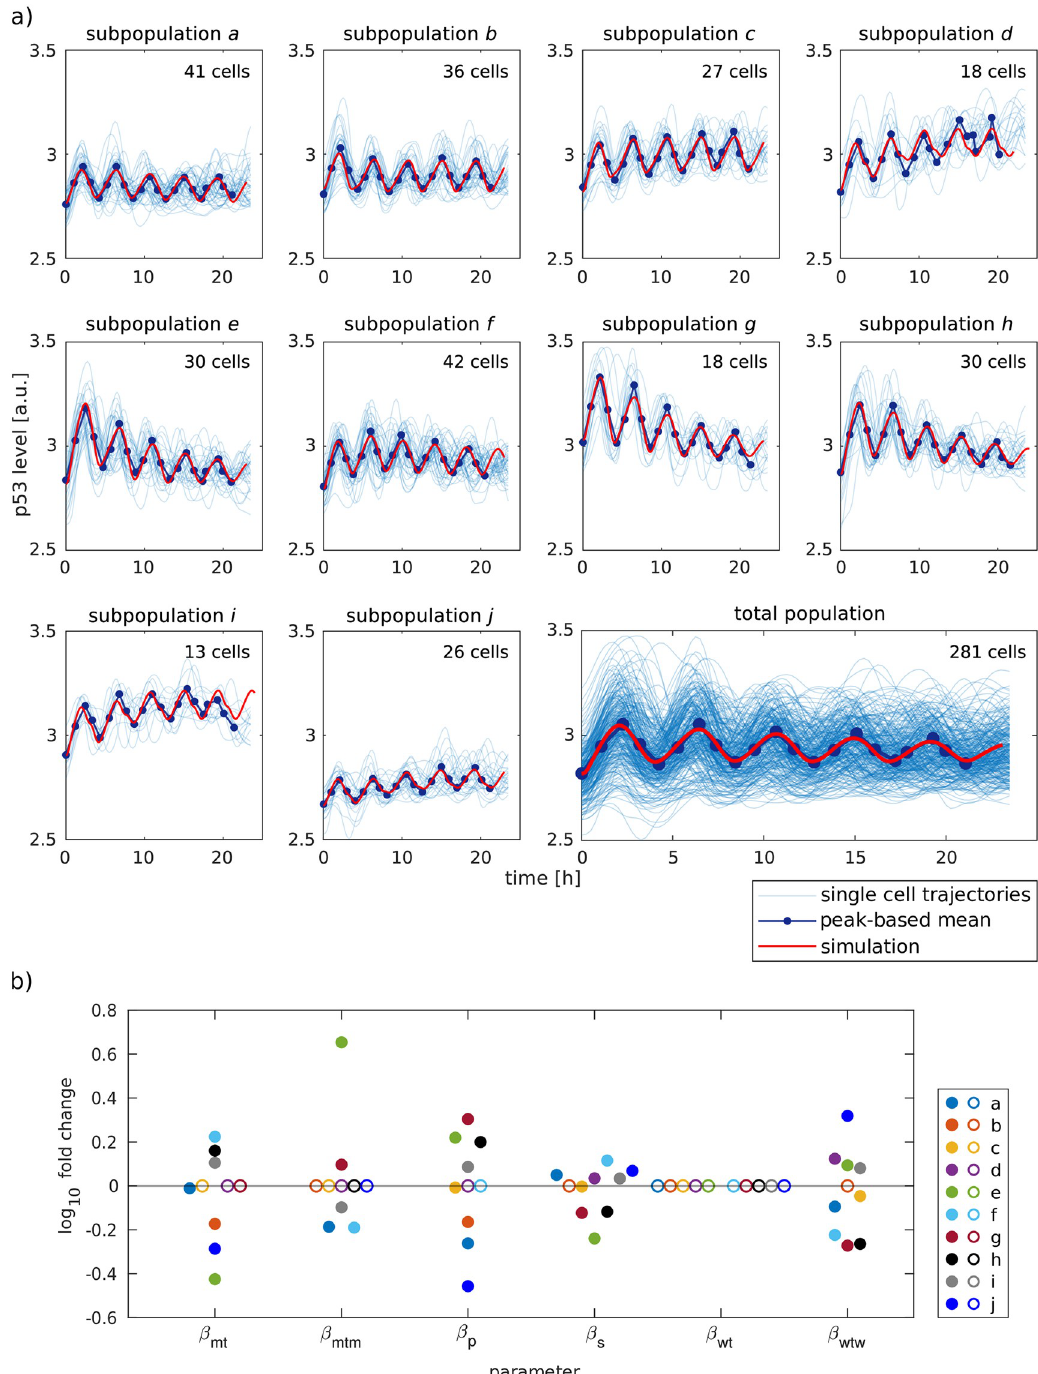
Fig 3. Model pool reproduces heterogeneous p53 dynamics. a) The ten models of the model pool were fitted to the peak-based mean of the ten subpopulations (blue lines). The red line indicates the simulation of the best fit. The number of cells assigned to a subpopulation is stated in the upper right corner of each subpopulation plot. To visualize the simulation and experimental data on the population level (lower right corner), the weighted mean over all subpopulations was calculated. The weight is determined by the number of assigned cells. b) L1 regularization-based evaluation of subpopulation-specific parameters. The parameters correspond to the six biochemical processes that were assumed to be subpopulation-specific. The processes include